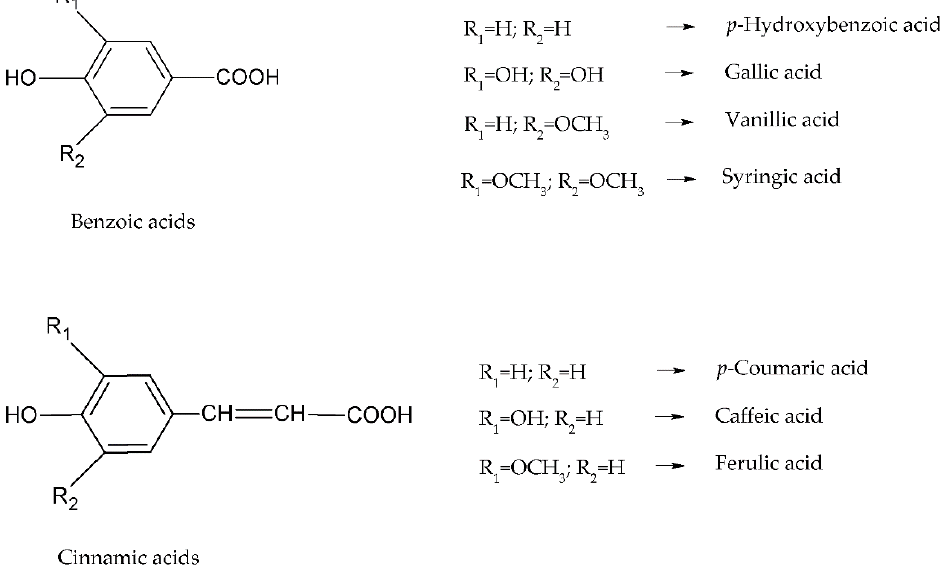
Figure 2. Phenolic acids. Adapted from References [18,20].